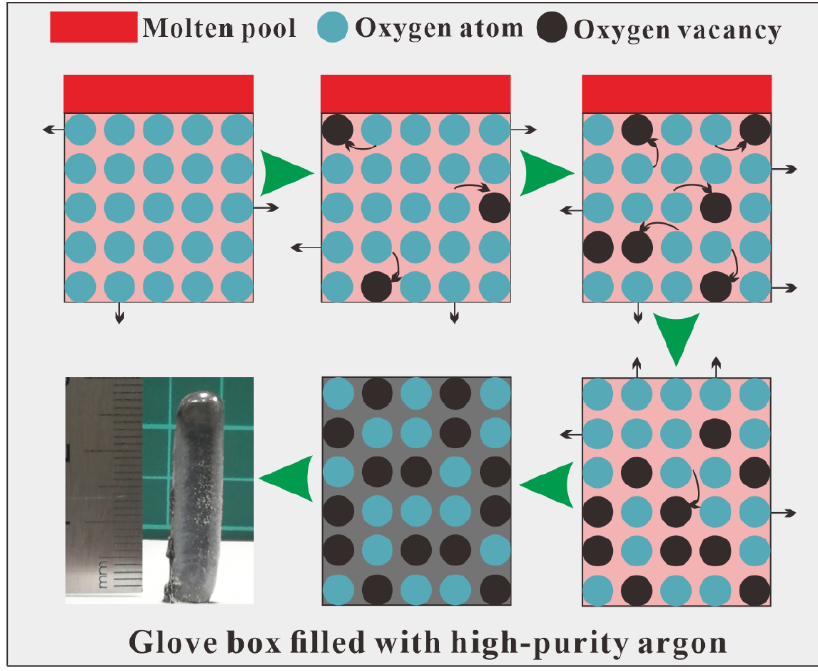
Fig. 6 Formation mechanism of the oxygen vacancies during the laser 3D printing